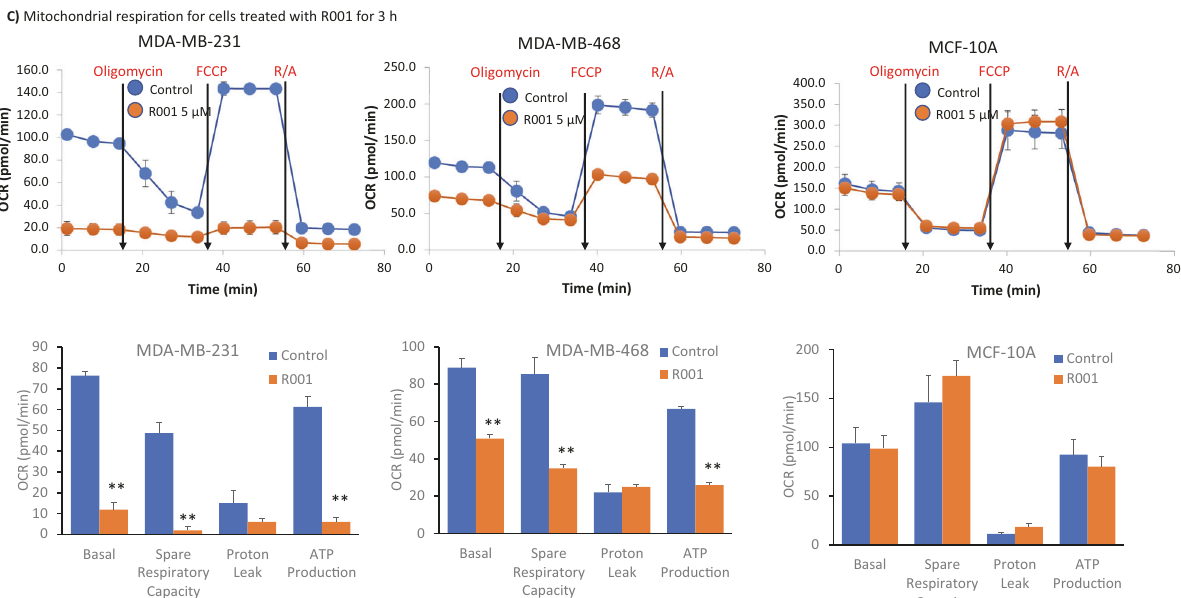
High levels of ROS and oxidative stress are associated with DNA damage [40]. Further, cell death mechanism, including pyroptosis